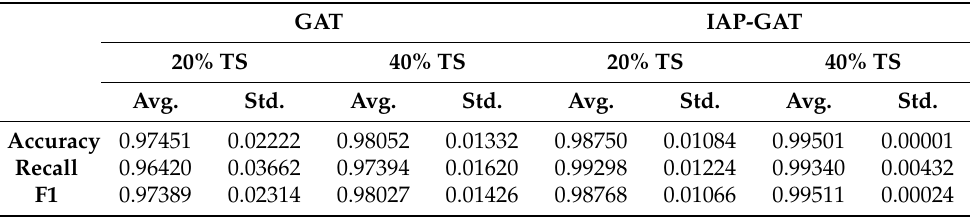
Table A2. Average and standard deviation values of the performance recorded in GGAT’s